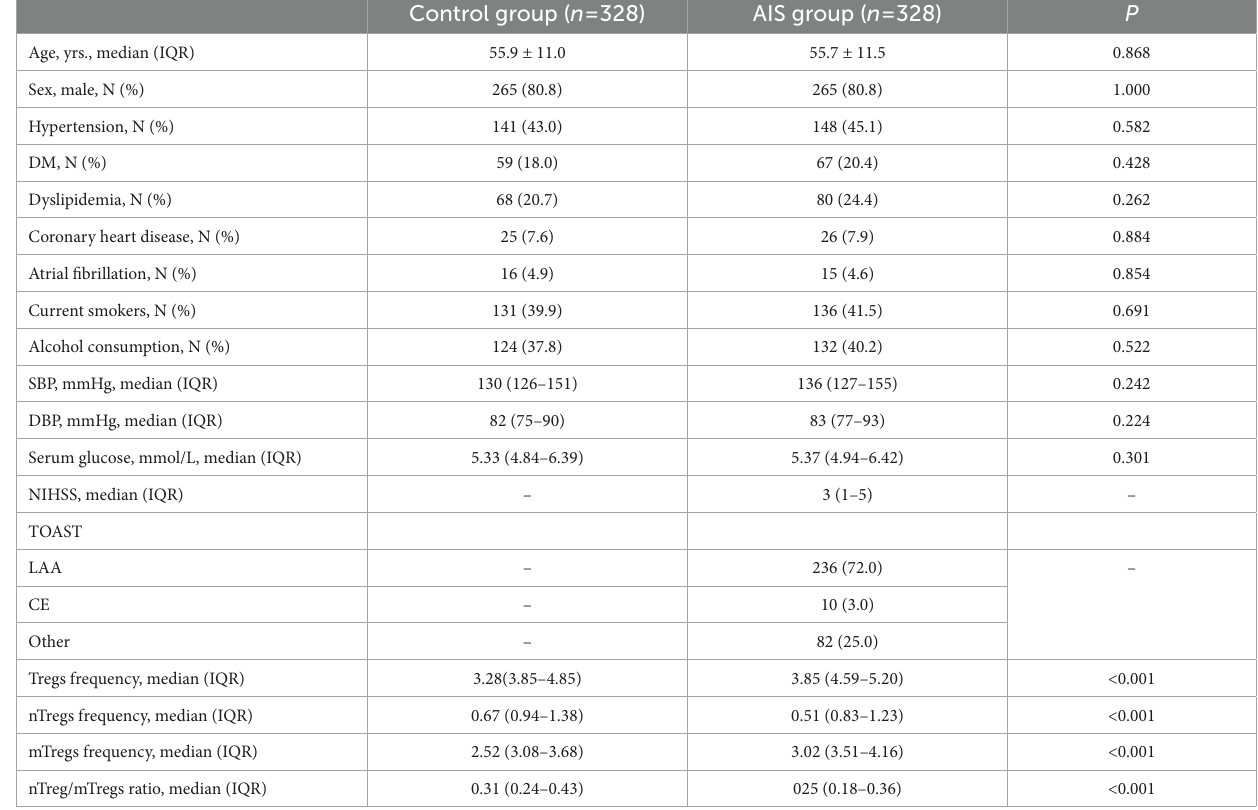
TABLE 1 Baseline characteristics of controls and participants with acute ischemic stroke